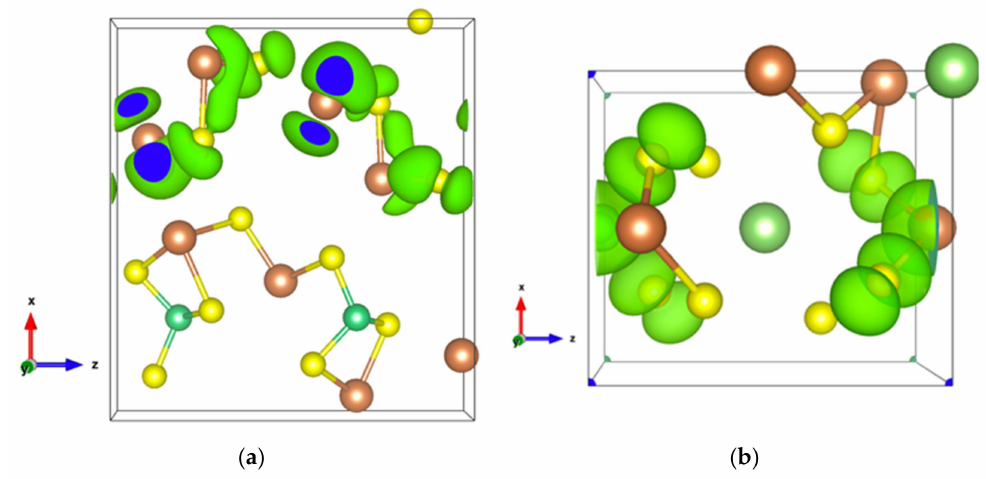
Figure 14. Electronic density of SbS 2 Ga 2 with an isosurface of 0.002 electrons / bohr 3 . ( a ) For the top valence orbital; ( b ) For the bottom conduction orbital.